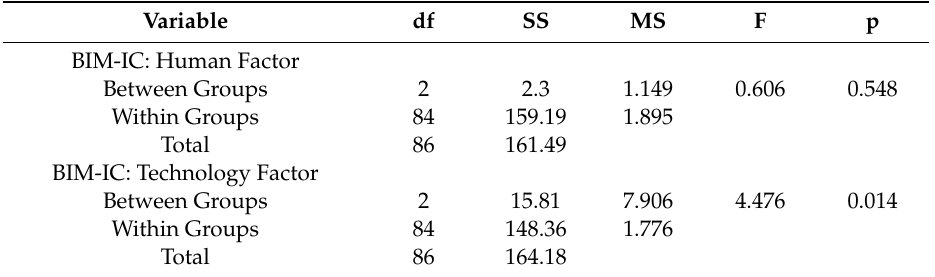
Table 7. One-Way ANOVA Project Characteristics for Successful BIM: Human and Technology Factor by Stakeholder